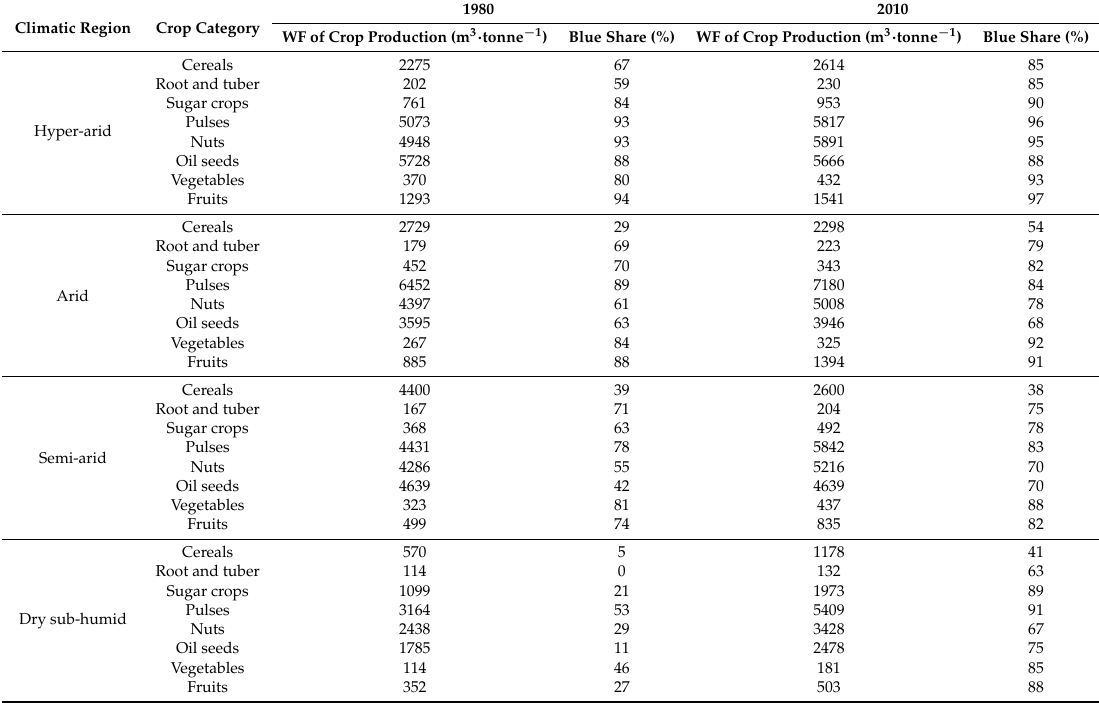
Table 1. Regional and national averages of the WF of crop production and the blue share in the total, per crop category, for the years 1980 and